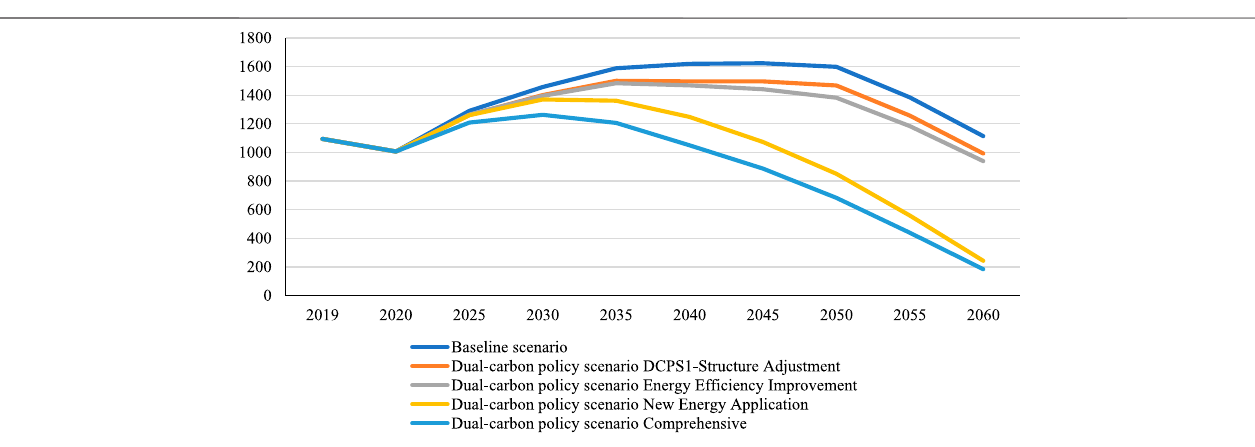
FIGURE 8 | Trends of carbon emissions using different policies and measures under the dual carbon policy scenario.